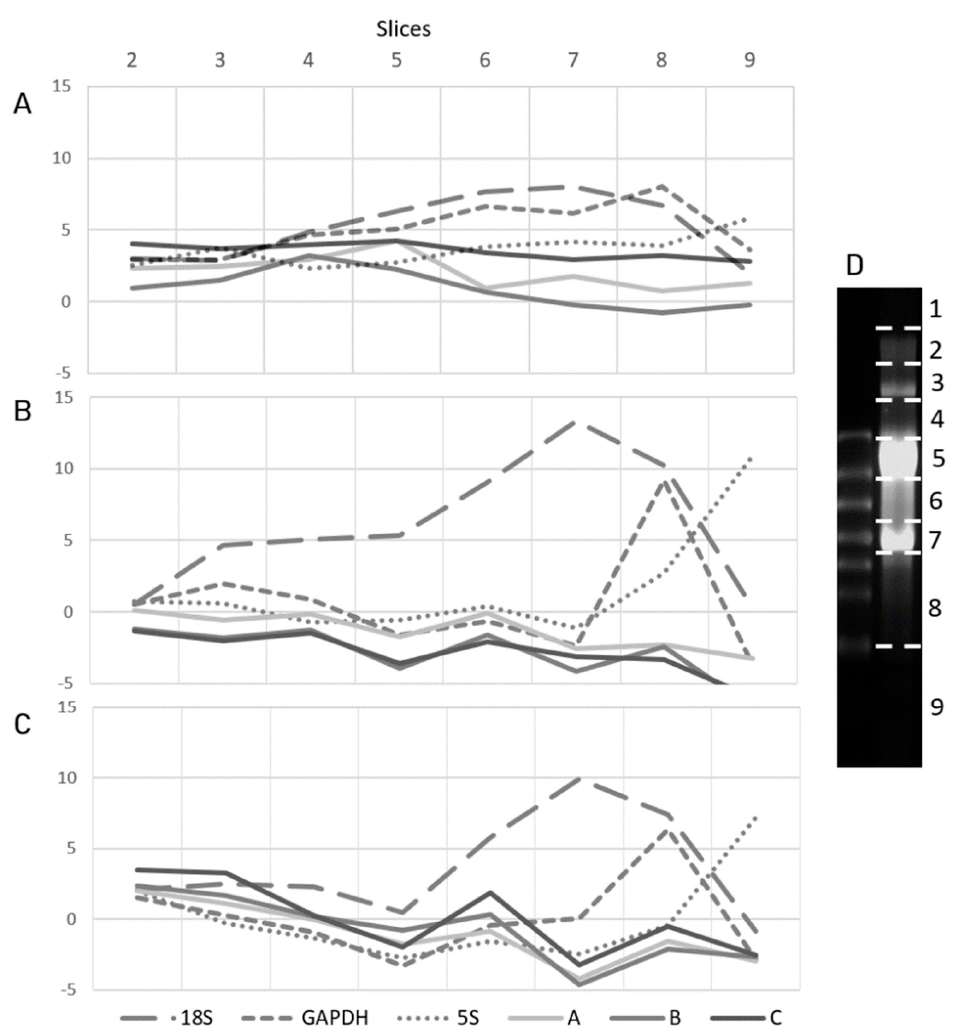
Figure 5. The preparation and analysis of RNA slices using RT-PCR. RT-PCR of slices obtained from ( A ) non-denaturing agarose gel electrophoresis of total RNA from non-treated cells, ( B ) denaturing agarose gel electrophoresis of total RNA from non-treated cells, ( C ) denaturing agarose gel electrophoresis of total RNA from alpha-amanitin treated cells (30 µg/mL) with the primer pairs for region of interest and reference genes; the graphs demonstrate the delta C T values obtained for each of the primer pairs during the normalization of the C T of each slice (2–9) to the C T of slice 1 ( Δ C T = C T (1) − C T (2, 3, etc.). ( D ) Electrophoresis of non-denatured total RNA in 1% agarose gel with the schematic representation of sections made; slices 5 and 7 contain 28S and 18S rRNAs correspondingly.